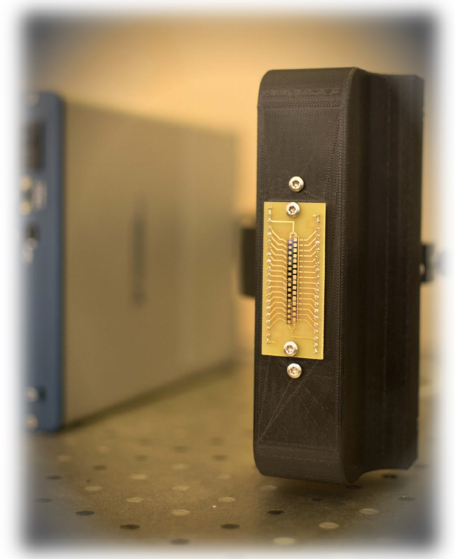
Figure 3. Photo of titanium-based microbolometer THz camera. It is composed of a linear array consisting of 2 lines with 16 pixels each. The left line is used for the detection of 700 GHz, and the right one for the detection of 300 GHz. It was realized via coupling of the sensors with antennas of relevant designs. The titanium bridge of 12 µ m and 2 µ m in length and width, respectively, was electrodeposited on the silicon nitride (SiN) membrane of 2- µ m thick. The membrane was etched to reduce the heat capacitance and to increase the speed of operation. More details can be found in Refs. [188,190]. Courtesy of Laboratory for Microelectronics of Faculty of Electrical Engineering